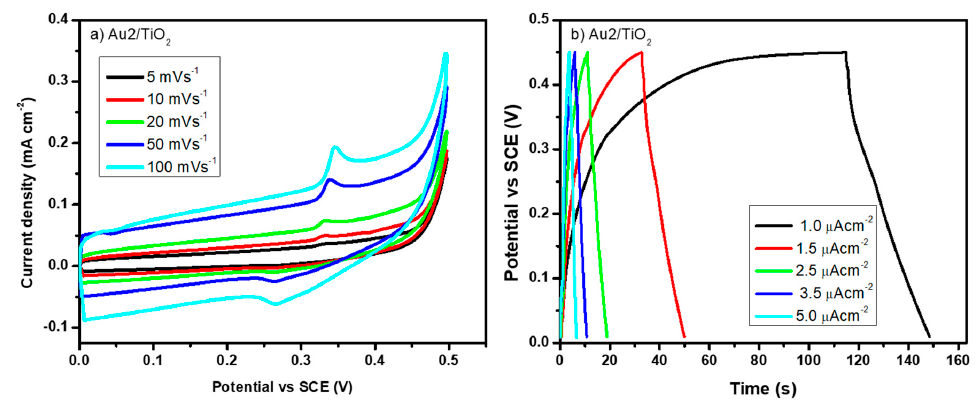
Figure 7. ( a ) CV curves of Au1/TiO 2 electrode measured at various voltage sweep rates and ( b ) GCD curves of Au1/TiO 2 electrode measured at various current densities.